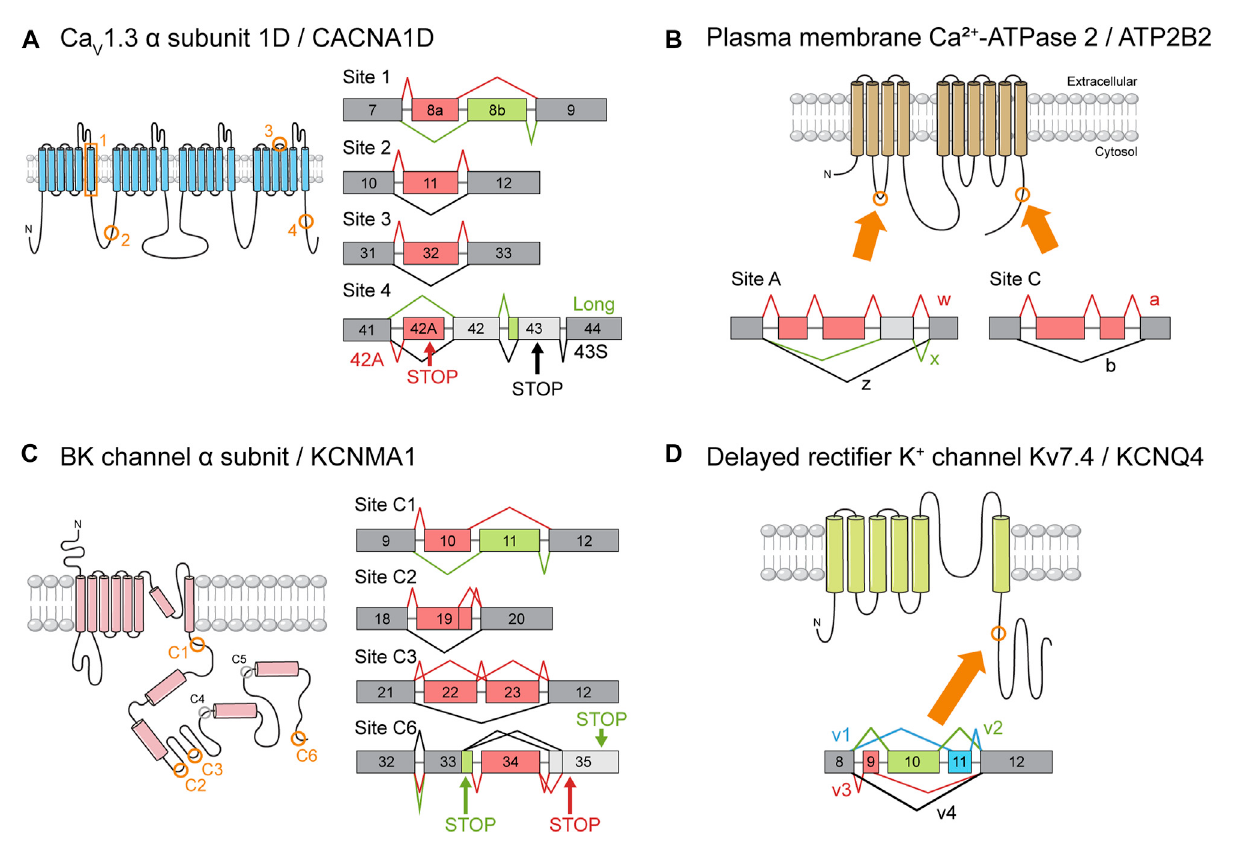
FIGURE 4 Ion channelgene splice variants. The structureof ion channelproteinsand important AS events. The proteinregions affected byAS ofeach channel are indicated by orange boxes or circles. The meaning of the color schemes is the same as in Figure 3. (A) Splice variants of Ca V 1.3 α subunit 1D (CACNA1D). Splice site numbering is arbitrary. Only some of the reported AS events are depicted. Please refer to Table S1. (B) Splice variants of plasma membraneCa 2+ -ATPase2(PMCA2). (C) Splicevariantsofthepore-formingBKchannel α subunit(KCNMA1).Cytoplasmicsplicesitesarecircled,and the sites reported to be utilized in murine inner ears by Miranda-Rottmann et al . (2010) are colored in orange. (D) Splice variants of delayed recti fi er K + channel Kv7.4 (KCNQ4) as identi fi ed by Beisel et al.